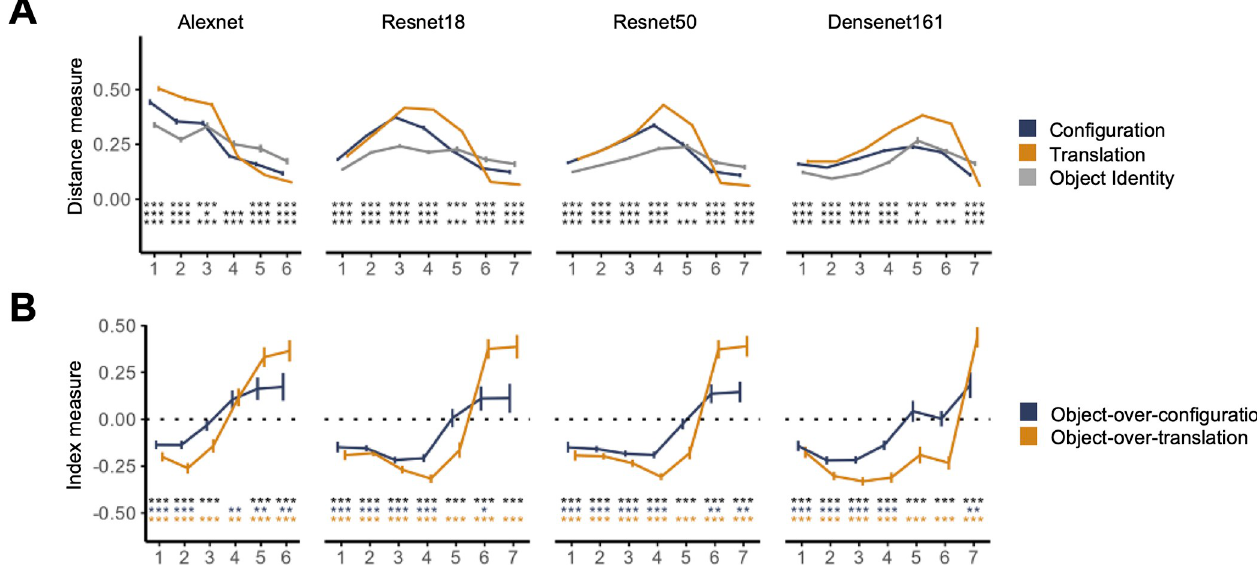
Fig 5. Euclidean distance and index measures comparing the effect of configuration change and translation. These two measures were obtained from scene-trained networks and quantify a CNN’s absolute and relative sensitivity to object identity and configuration changes as well as left/right translation. ( A ) Euclidean distances for changes in configuration, translation and object identity. The Euclidean distance for “Configuration” was calculated as the distance between two images sharing the same objects and translation but different configurations. Euclidean distance for “translation” was calculated as the distance between two images sharing the same objects and configuration but different translation. The Euclidean distance for “Object Identity” was calculated as the distance between two images sharing the same configuration and translation but different objects. ( B) The object dominance indices for configuration change and translation. The object-over-configuration indices measured the relative sensitivity to object identity and configuration changes, with negative values indicating greater sensitivity to configuration than identity changes and positive values the reverse. The object-over-translation indices measured the relative sensitivity to object identity and translation changes, with negative values indicating greater sensitivity to translation than identity changes and positive values the reverse. The asterisks indicate the significance levels of the pairwise comparisons made at each sampled layer using two-tailed t tests (all corrected for multiple comparisons). In (A), the asterisks from the top to bottom rows indicate, respectively, differences between “Configuration” and “Translation”, between “Configuration” and “Object Identity”, and between “Translation” and “Object Identity.” In (B), the asterisks from the top to bottom rows indicate, respectively, differences between the two index measures, differences between the object-over-configuration indices and zero, and differences between the object-over-translation indices and zero. Error bars indicate within-image sets 95% confidence intervals of the means. � p < .05, �� p < .01, ��� p < .001. The plotting lines are slightly shifted horizontally to minimize